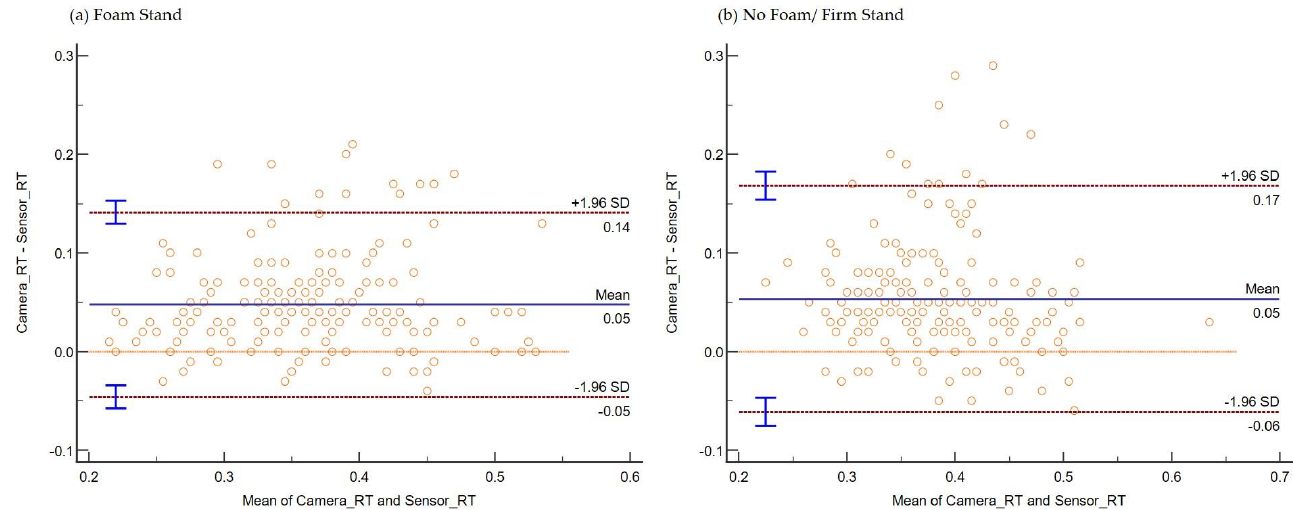
Figure 7. Plot differences between RT from the camera and sensor systems versus the mean of two